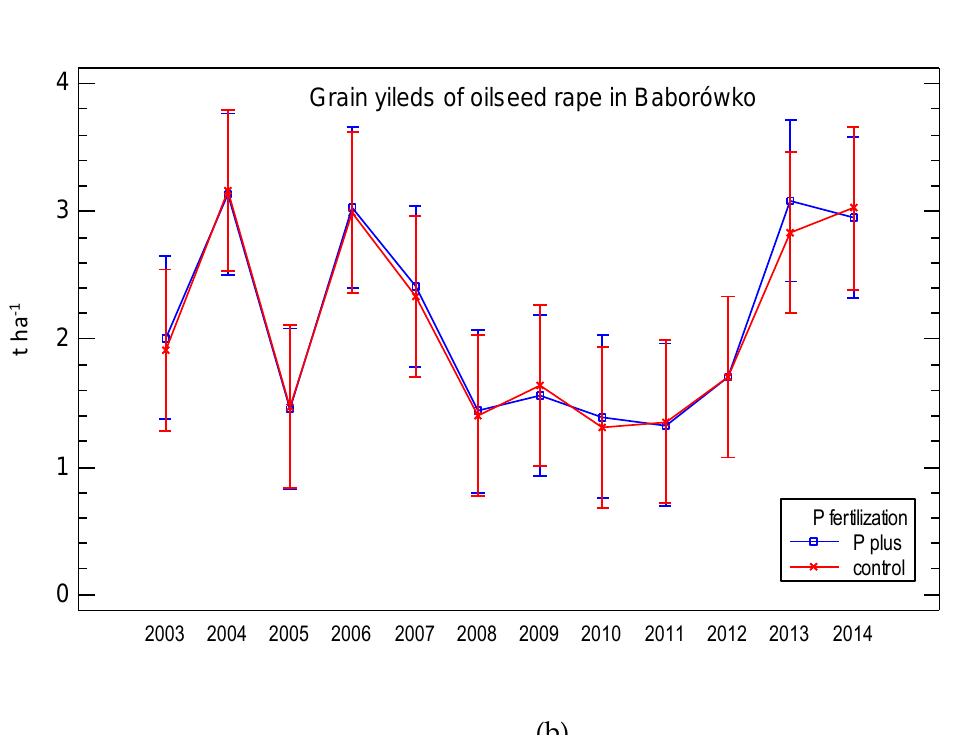
Figure 1. Grain yields of winter oilseed rape in (a) Grabów and (b) Baborówko; 95% Tukey Honest Significant Difference test (HSD) intervals; n = 336 for Grabów and n = 288 for Baborówko.